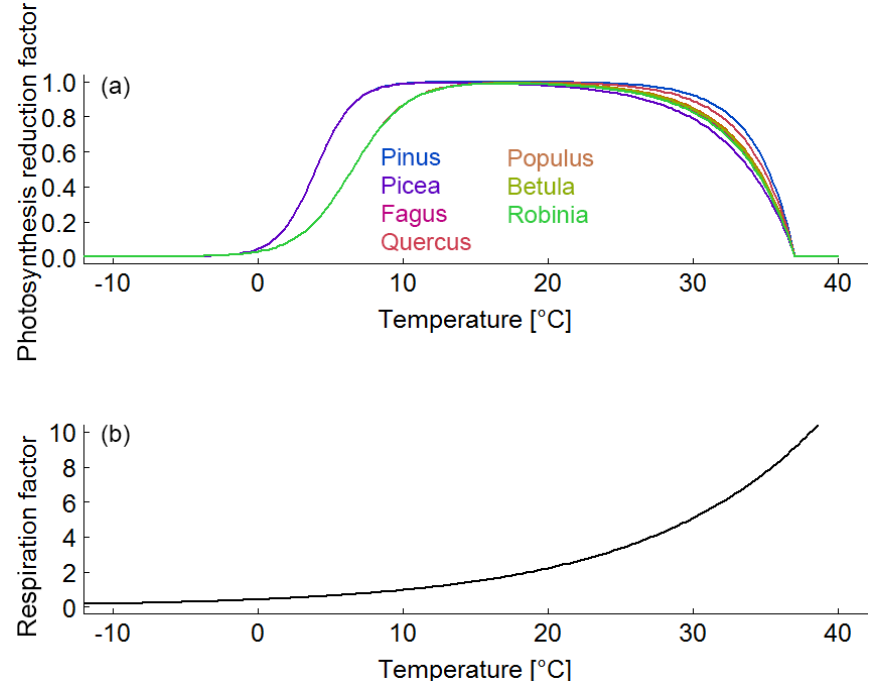
Figure B5. (a) Species-specific reduction factor of photosynthesis due to a change in air temperature. (b) Species-unspecific correction factor for maintenance respiration due to a change in air